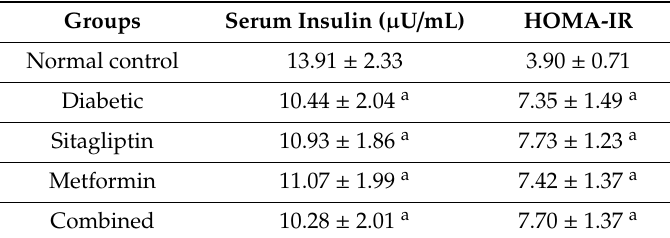
Table 3. Baseline values of serum insulin and HOMA-IR of the different studied groups.